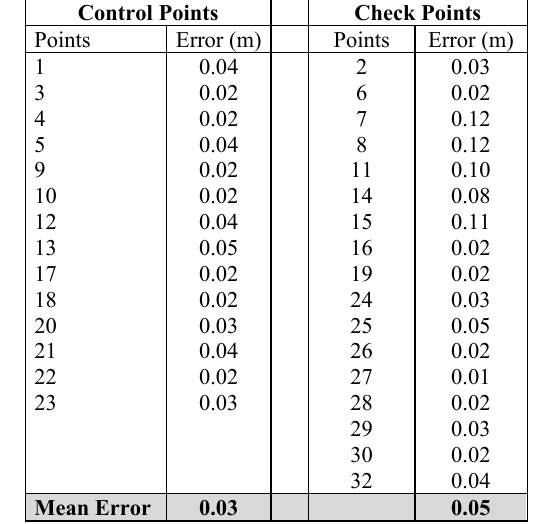
Table 3. Control and check points 3D residuals.